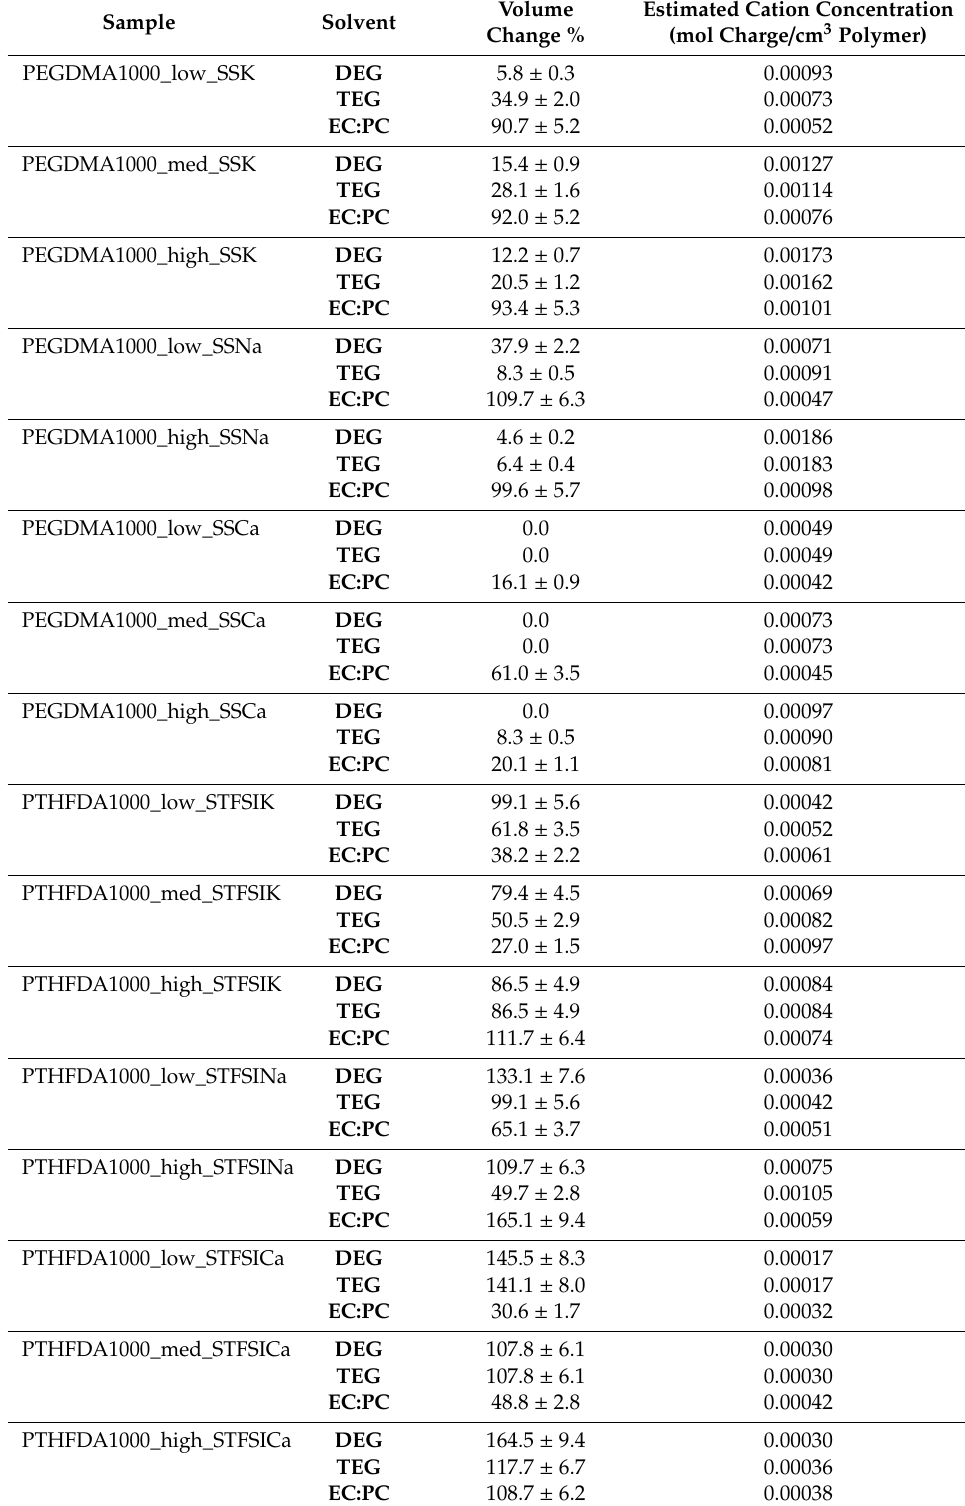
Table A1. Volume change % for SIPEs in a given solvent. Calculated using swelled thickness and assuming isotropic